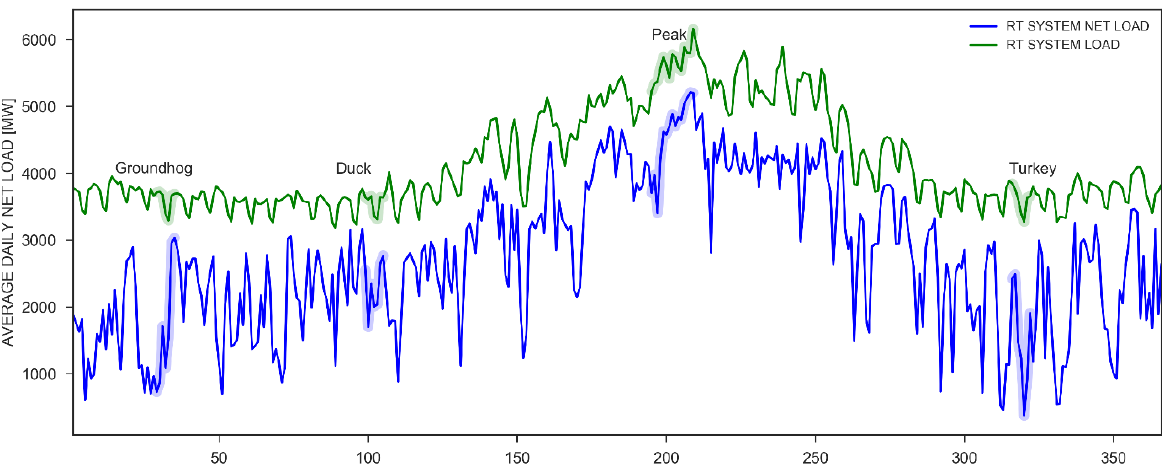
Figure 4. Average net load per day of the year occurring in the RTS-GMLC.